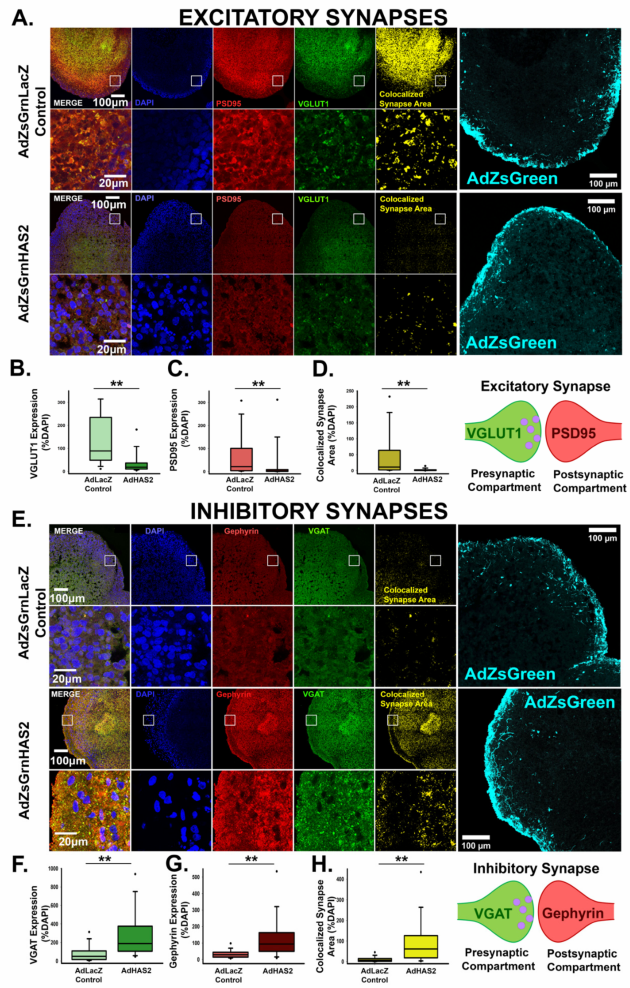
Figure 4. Hyaluronan synthase, HAS2, alters the emerging balance between excitatory and in- hibitory synapses in developing neural networks. ( A ) Representative images of cortical spheroids transduced with either LacZ control or HAS2 and stained for DAPI (blue) and excitatory synapses: post-synaptic marker PSD95 (red) and pre-synaptic marker VGLUT1 (green). Right panel shows the excitatory synaptic colocalization of PSD95 and VGLUT1 in yellow. Bottom panel highlights the region of the cortical plate indicated by the white box. Scale bars: top: 100 µ m, enlarged region: 20 µ m. ( B ) Quantification of the area of pre-synaptic marker VGLUT1 normalized to the area of DAPI. ( C ) Quantification of area of post-synaptic marker PSD95 normalized to the area of DAPI. ( D ) Quantification of colocalized excitatory synapse area normalized to the area DAPI. n = 9 total spheroids for each transduction (AdZsGrnLacZ and AdZsGrnHAS2). Spheroids were derived from 3 separately grown and transduced spheroid sets ** p < 0.001 for ( B – D ). ( E ) Representative images of transduced cortical spheroids stained for DAPI (blue), and inhibitory synapses: post-synaptic marker gephyrin (red) and pre-synaptic maker VGAT (green). Rightmost panel shows the inhibitory synaptic colocalization of gephyrin and VGAT in yellow. Bottom panel highlights the region of the cortical plate indicated by the white box. Scale bars: top: 100 µ m, enlarged region: 20 µ m. ( F ) Quantification of the area of pre- synaptic marker VGAT normalized to the area of DAPI. ( G ) Quantification of the area of post- synaptic marker gephyrin normalized to DAPI. ( H ) Quantification of colocalized inhibitory synapse area normalized to the area of DAPI. n = 9 total spheroids for each transduc- tion (AdZsGrnLacZ and AdZsGrnHAS2). Spheroids were derived from 3 separately grown and transduced spheroid sets ** p < 0.001 for ( F – H